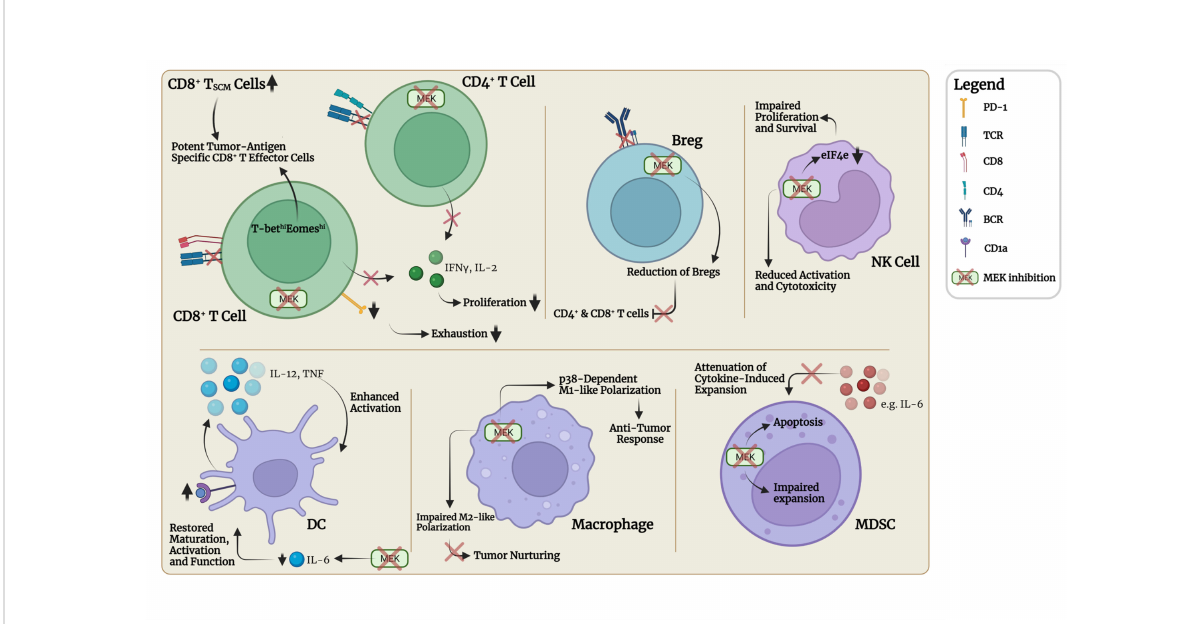
FIGURE 4 MEK inhibition and associated immunomodulatory effects in the TME (marked with red boxes). MEKi interrupts immune evasion mechanisms and tumor crosstalk with stromal cells and restores an anti-tumorigenic microenvironment by increasing the expression and/or release of proin fl ammatory molecules, e.g., CD40L, IFN g , TNF, and CD40L, while simultaneously reducing the presence of immunosuppressive cytokines, e.g., IL-6, IL-10, GM-CSF, and IL-6, and suppressive cell populations such as Tregs, Bregs, MDSCs and M2-polarized macrophages. MEKi